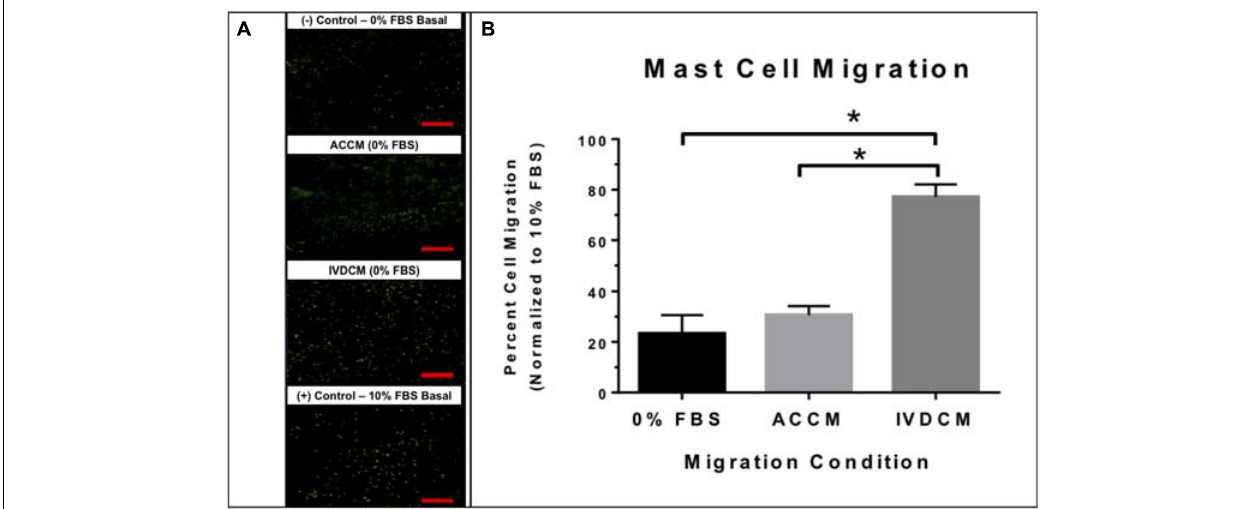
FIGURE 2 | (A) Representative images of (calcein) stained fluorescent MCs migrating in response to 0% FBS BMC (negative control), 0% FBS ACCM (cell control), 0% FBS IVDCM, and 10% FBS BMC (positive control). (B) Mast cell migration in response to IVDCM ( N = 3), ACCM ( N = 3) and 0% FBS (negative control) ( N = 6) normalized to 10% (positive control = 100% migrated cells) ( N = 6; ∗ p ≤ 0.05). Red scale bar = 500 µ m (4 × ).